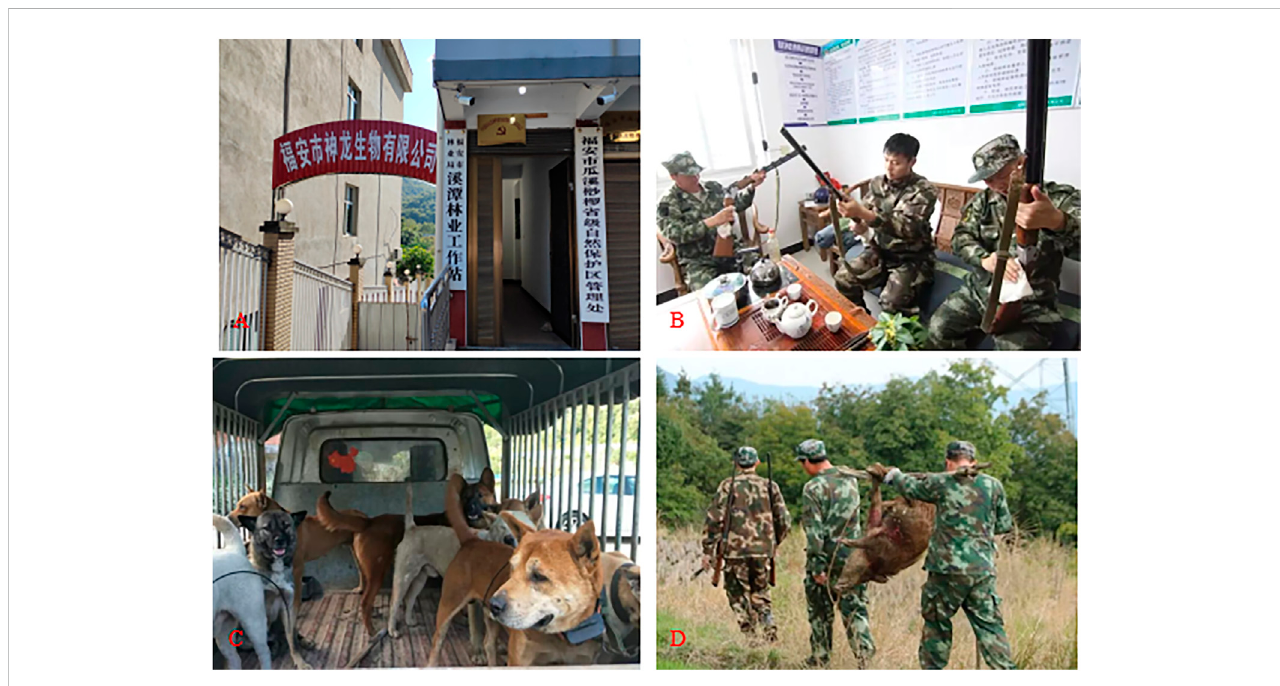
FIGURE 6 Government dominated hunting: (A) Authorized only one professional corporation (B) Gun maintenance (C) Hunting dogs (Chinese rural dog, the colorful fur was inherited from the ancient wolf) (D) Returned from